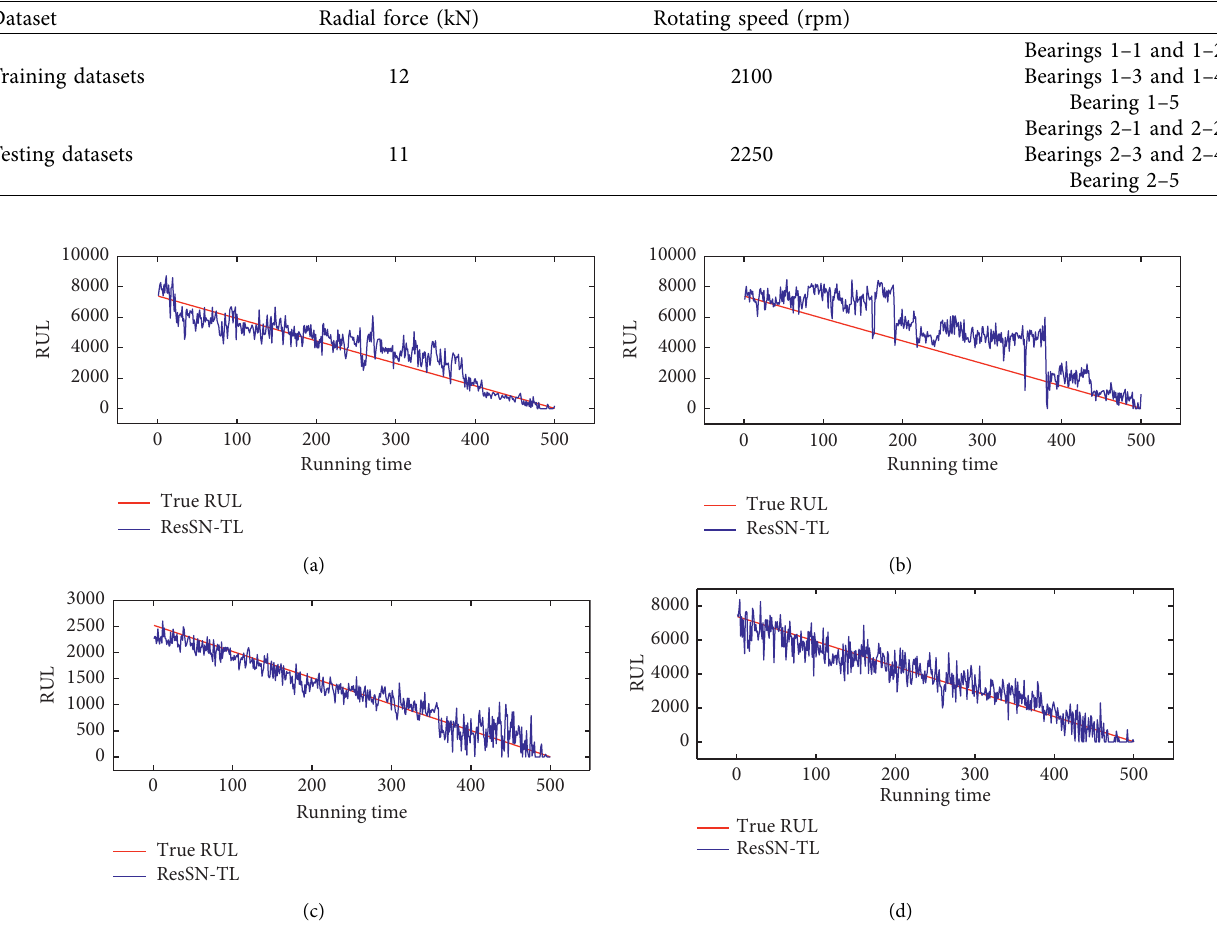
Figure 10: RUL prediction results of bearing dataset 2–4. (a) RNN, (b) LSTM, (c) GRU, (d) Bi-LSTM, (e) ResSN, and (f) ResSN-TL. Table 5: Experimental data.